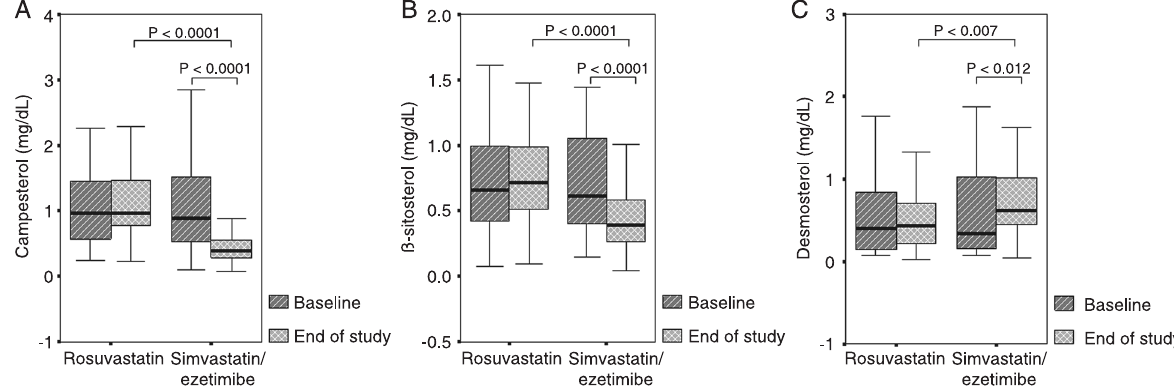
Figure 1. Box-plots (median, 25th and 75th percentiles) for plasma levels of campesterol ( A ), β-sitosterol ( B ), and desmosterol ( C ) at baseline and at the end of the study according to treatment. Baseline values were comparable between groups. Rosuvastatin did not modify these parameters over time. Subjects treated with simvastatin/ezetimibe presented a reduction of plasma levels of campesterol and β-sitosterol (P < 0.0001 vs baseline for both, Wilcoxon test), and an increase of desmosterol (P = 0.012 vs baseline, Wilcoxon test). Plasma campesterol and β-sitosterol levels were lower at the end of the study (P < 0.0001 for both, Mann-Whitney test) in subjects receiving simvastatin/ezetimibe compared to individuals receiving rosuvastatin, whereas desmosterol levels were higher (P = 0.007, Mann-Whitney test).